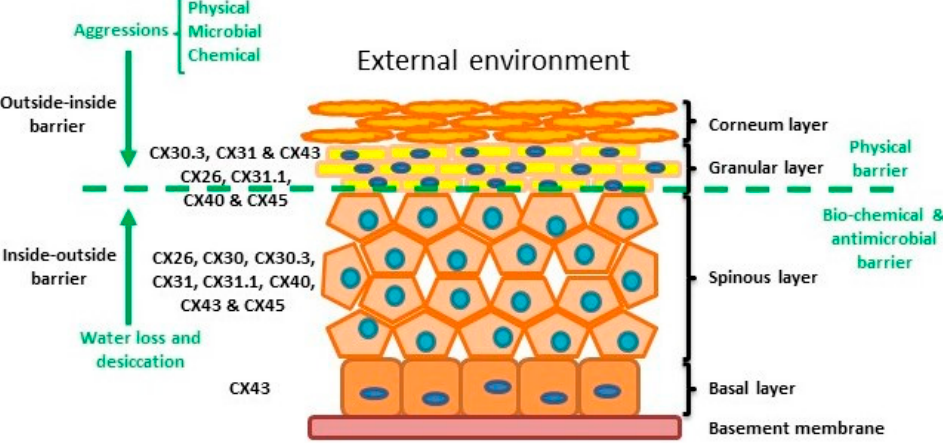
Figure 2. Structure of the epidermis indicating connexin expression profile and barriers.